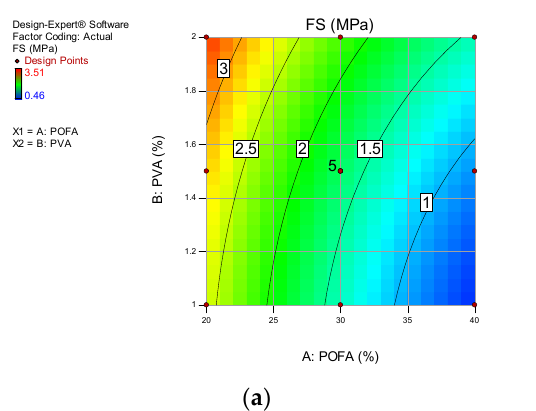
( b ) Figure 23. ( a ) 2D Contour Plot and ( b ) 3D Response Surface Diagram for Tensile Strain Capacity. 4.2. Multi-Objective Optimization An effort at optimizing the system is made to discover what values of the independ- ent variables should be used to attain the highest possible level of the response of interest. Attaining the objective function may be completed by creating objectives for the variables (input factors and responses) that have various criteria and degrees of relevance. When evaluating the optimization, the desirability value, which ranges from 0 to 1, is used. The closer the value is to one, the more favourable the result [28].